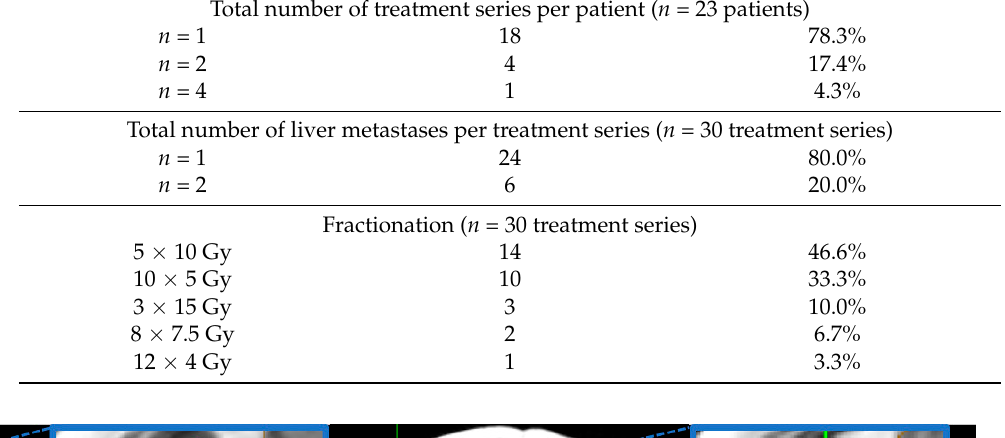
Table 2. Treatment series characteristics.